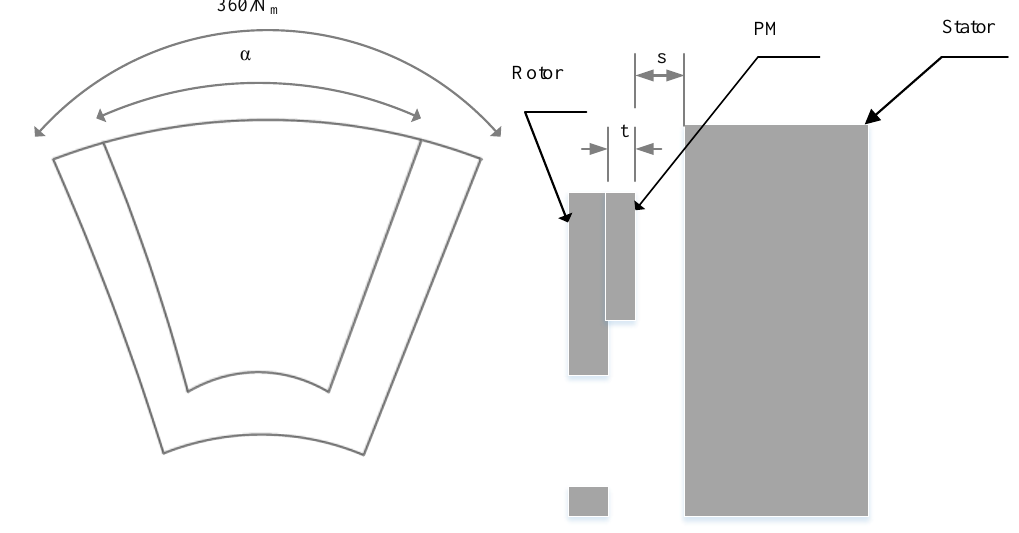
Figure 4. Surfaces of the rotor–stator